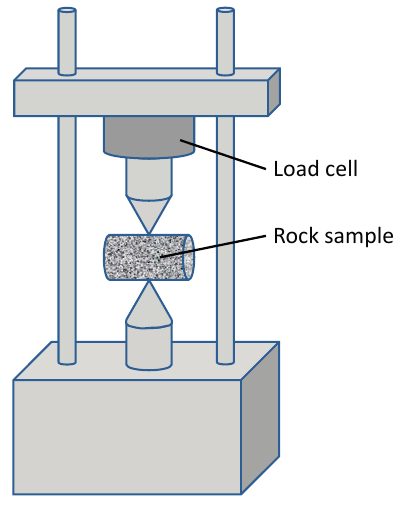
Figure 3. Point load